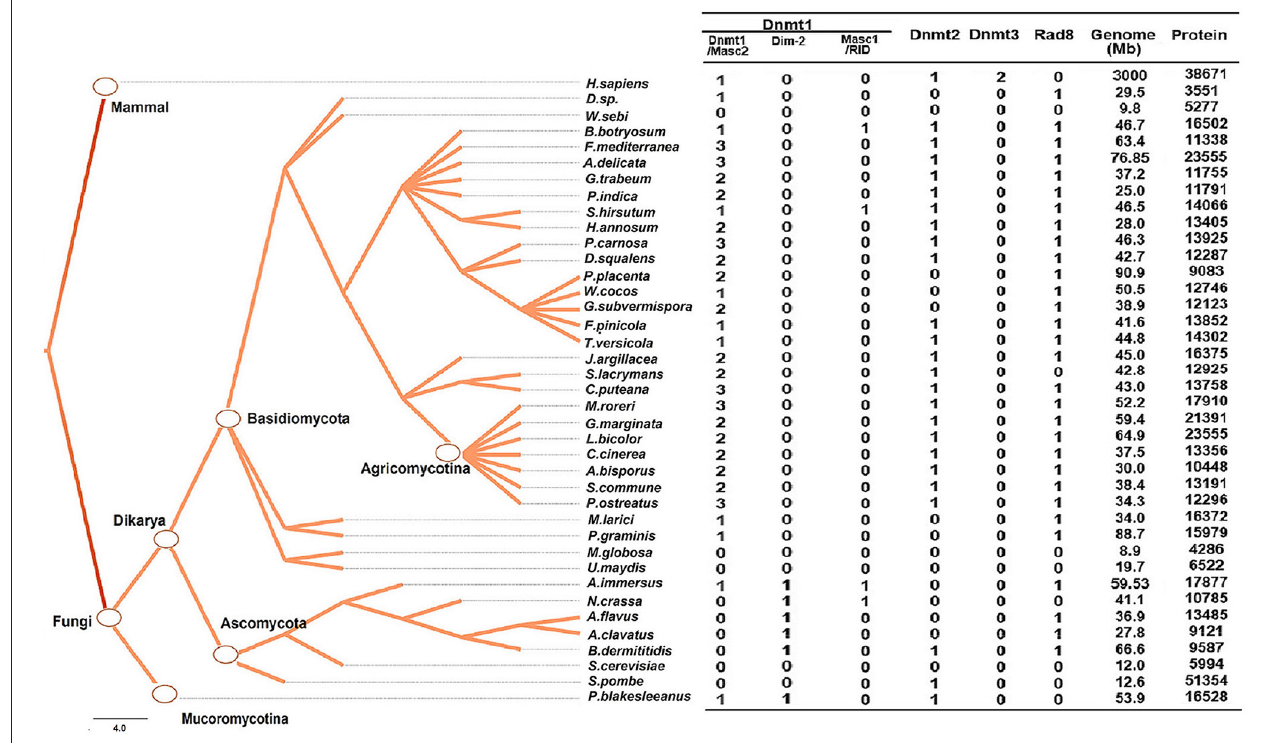
FIGURE 1 | Numbers of genes encoding DNA methylase domain-containing proteins in the 39 species investigated. The Taxonomy Common Tree constructed by Taxonomy Browser in NCBI (National Center for Biotechnology Information) is shown on the left. The number detail of each category of each species is listed at the right column. The species lacking gene encoding DNA methyltransferase were also verified by online tblastn toolset of NCBI. domain) occurred in other kingdoms or solely in